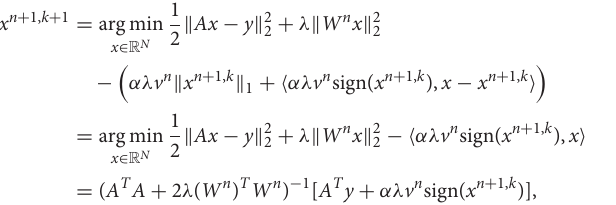
0.3 and r 0.7 in the noise free case, while varying the sparsity level s = =